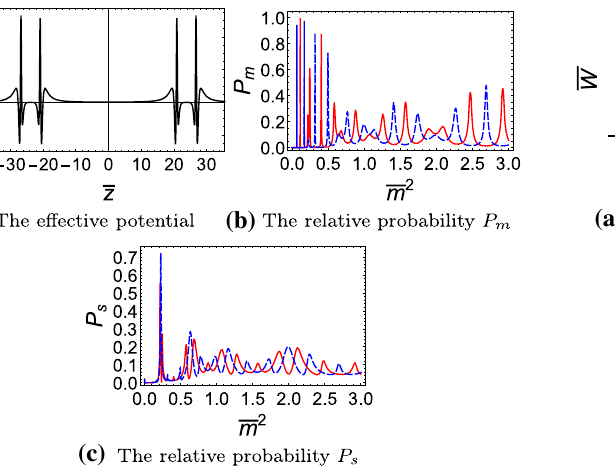
Fig. 23 The effective potential, the relative probabilities of the even parity KK mode ψ e (dashed blue lines) and the odd parity KK mode ψ o (solid red lines) quasi-localized between the sub-wells P m and in the sub-wells P s with ¯ b = 13, ¯ d = 2 . 3, and ¯ α = − 0 . 0838 for case 3